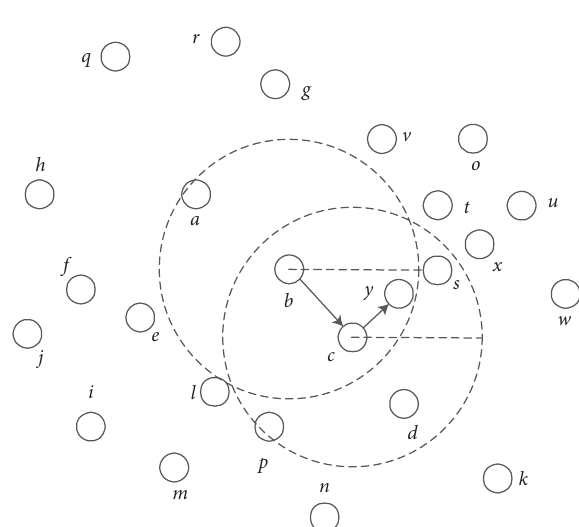
Figure 6: Example of random select node.